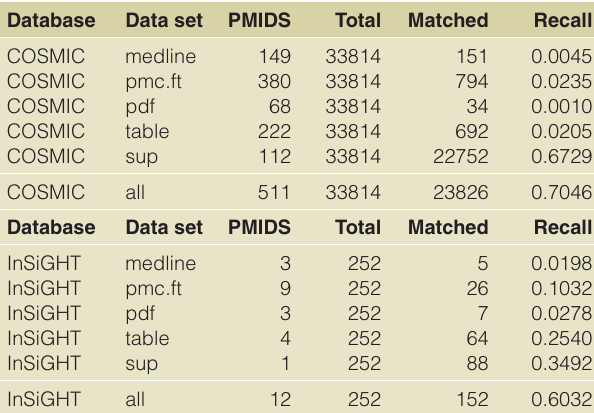
(pdf), tables available from the Open Access PMC Articles’ XML (table), supplementary material (sup) and the combination from all the sources (all).